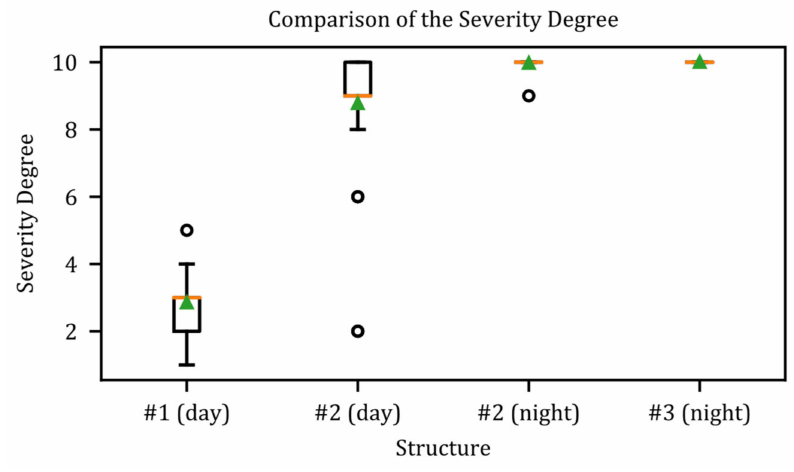
Figure 15. Comparison of the severity degree for three di ff erent